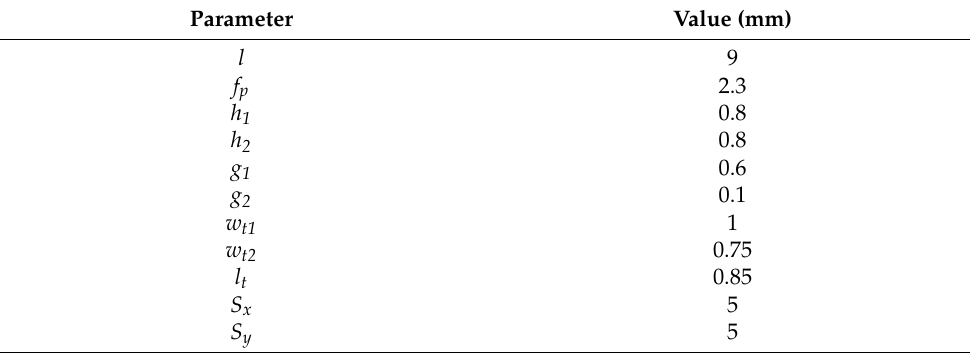
Table 1. Geometrical parameters of the proposed antenna.